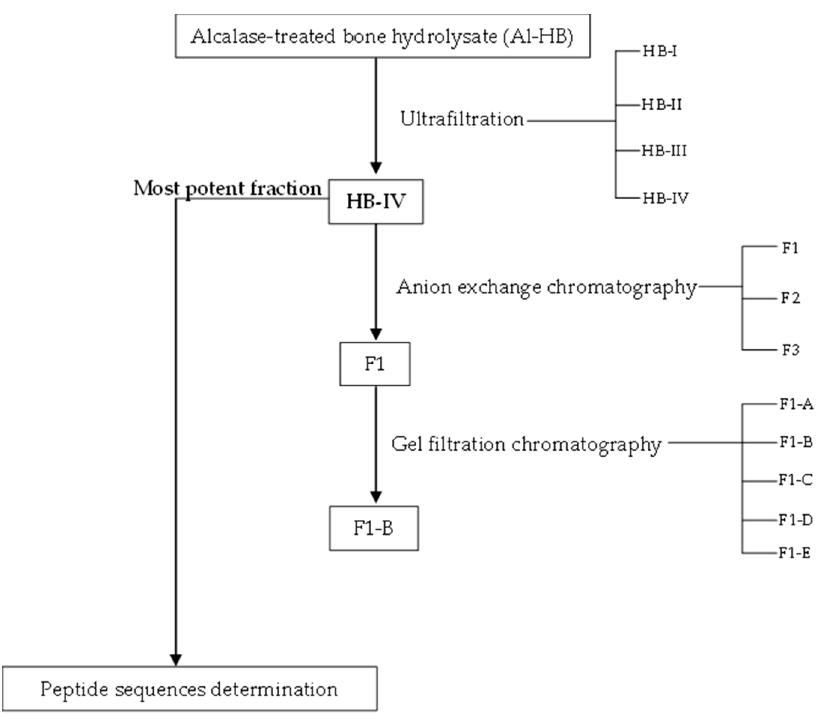
Figure 1. Process flow diagram for the separation of ACE ‐ inhibitory and antioxidant peptides from the Alcalase ‐ treated bone hydrolysate.